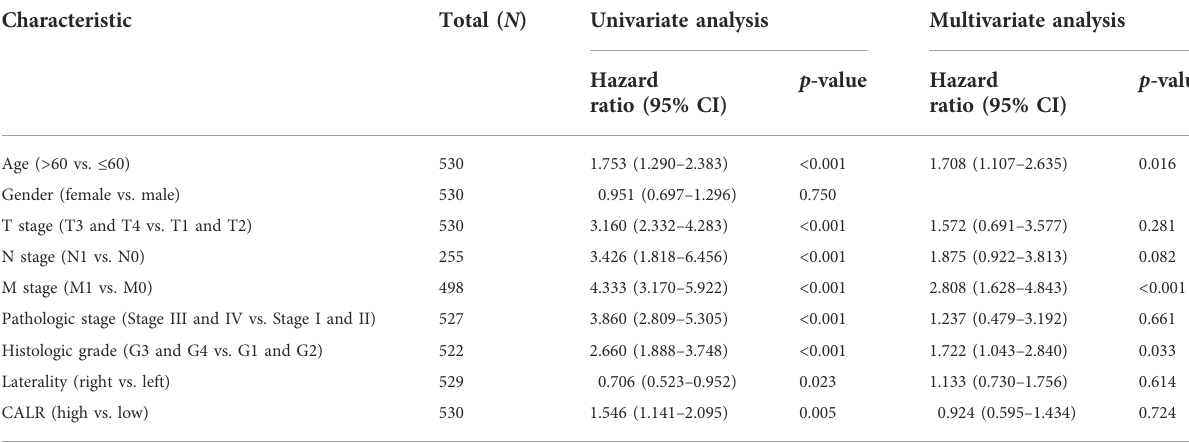
Hazard ratio (95%